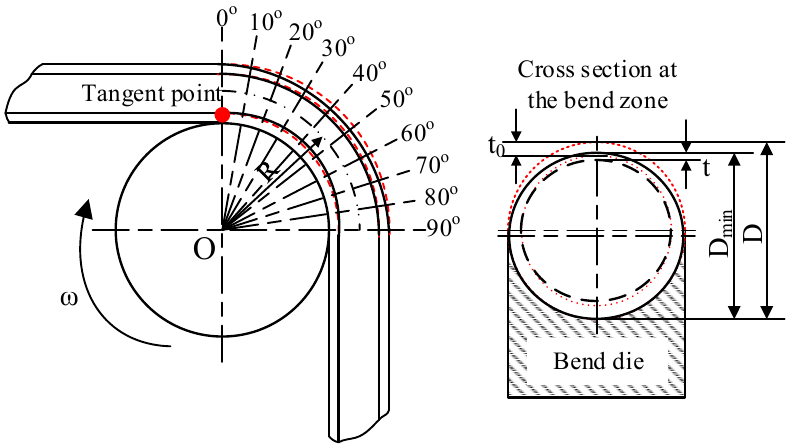
Figure 6. Schematic diagram of micro-tube RDB and bending defects.